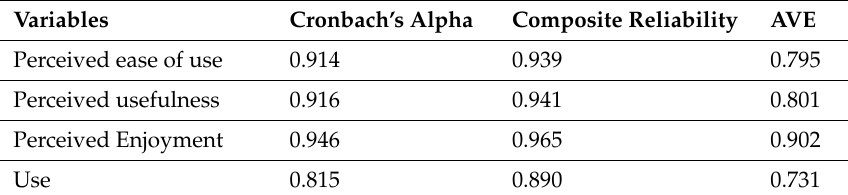
Table 3. Validity and reliability of the cross-sectional study.